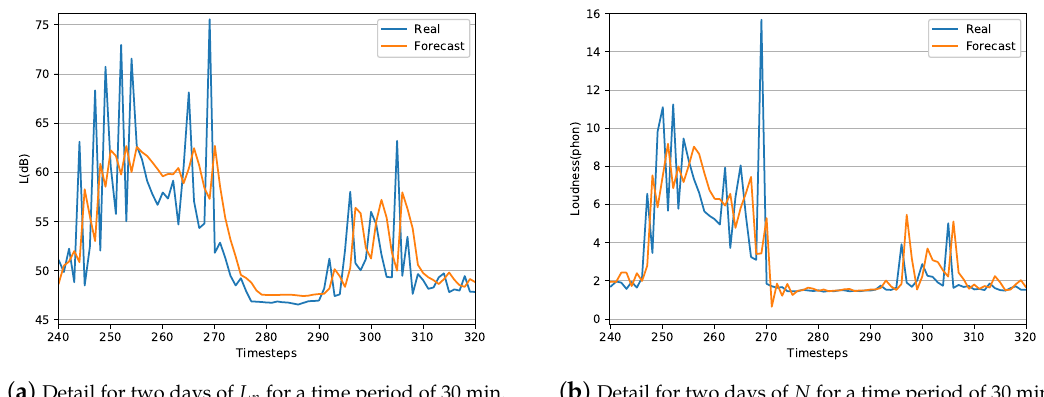
Figure 4. Detailed representation for two days, Friday and Saturday, for a time period of 30 min of captured and estimated LSTM